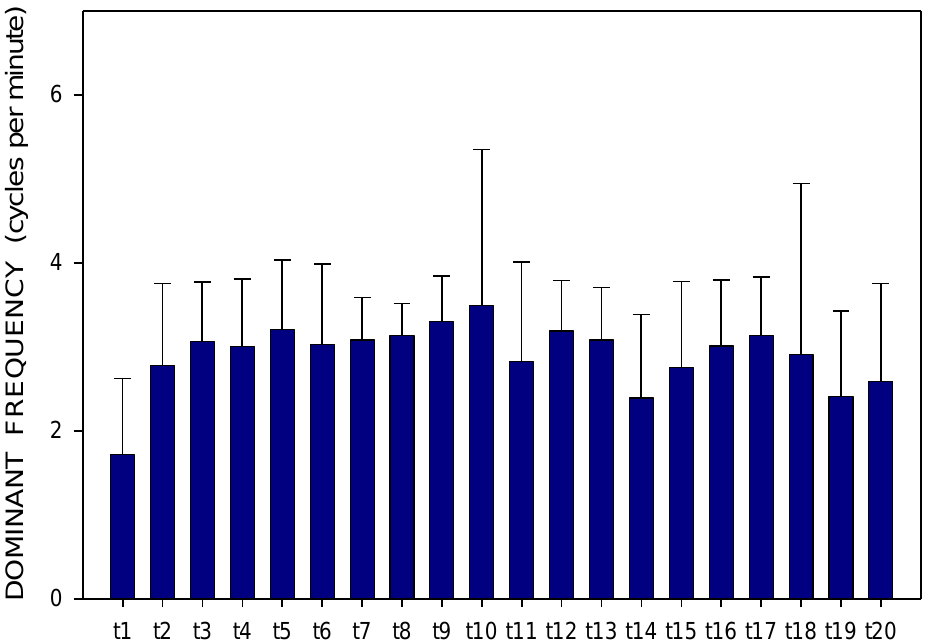
Figure 9. Electrogastrography. Dominant frequency in animals with a longer small bowel transit time (486 ± 93 min); mean + standard deviation. Explanatory note: t: 15-min study recordings after galantamine administration (t1: time interval between 0–15 min ... t20: time interval between 286–300 min).